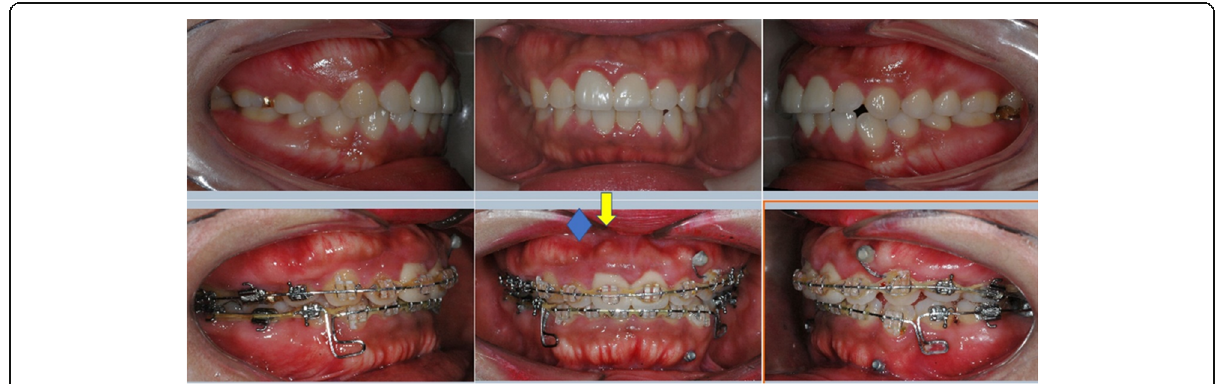
Fig. 6 Esthetically compromised alveolar bone irregularity are shown during incisors intrusion and retraction. Arrow indicated insufficient alveolar bone remodeling under maxillary central incisor involves from B1 to B3 level, while diamond indicated that only B3 level irregularity is shown